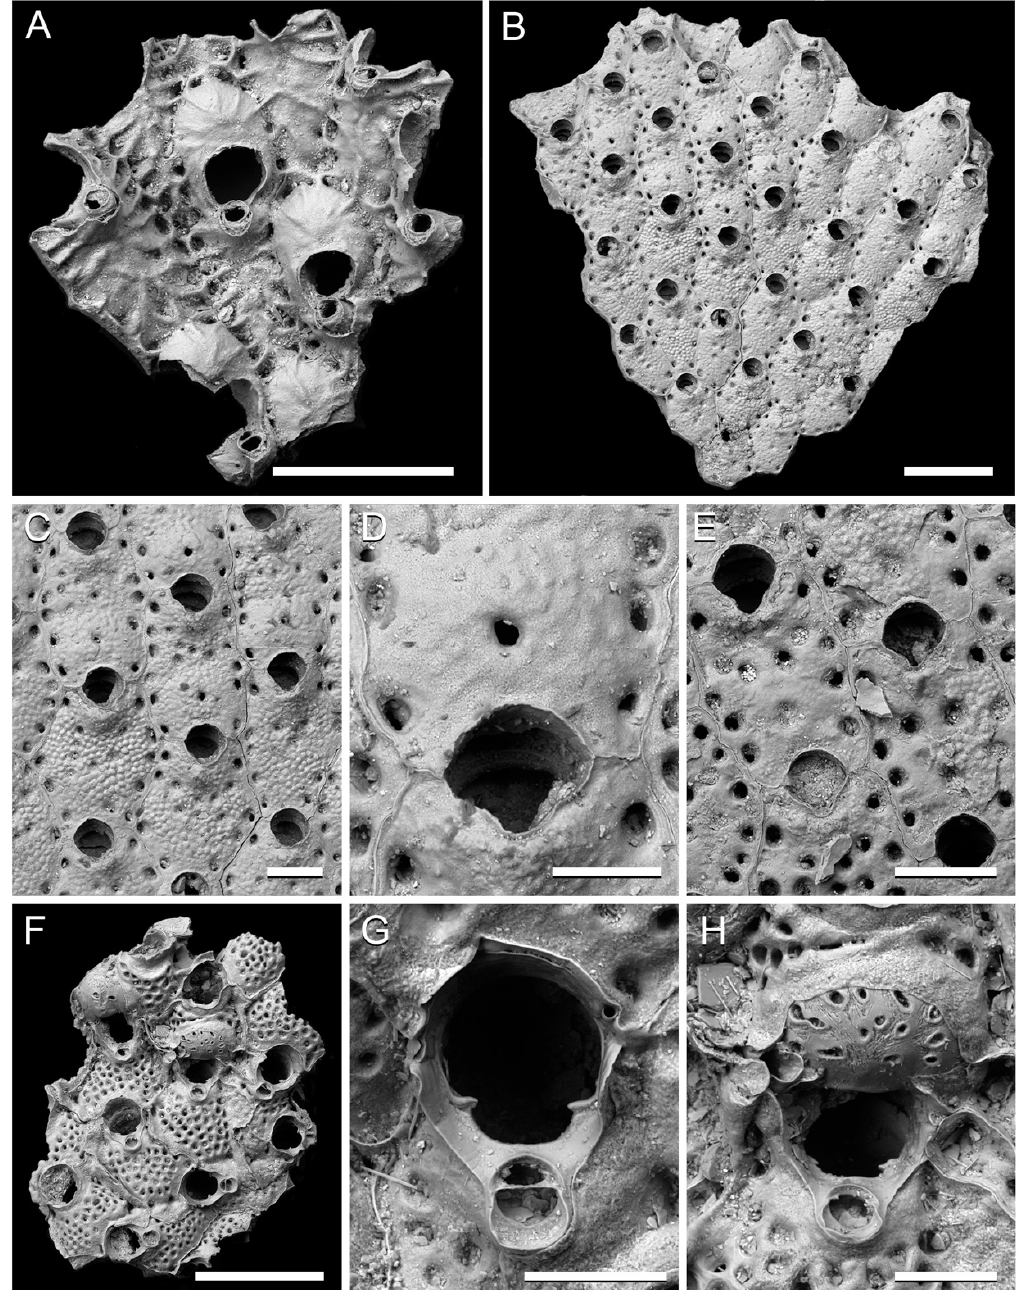
Figure 6. Cheilostome bryozoans from the Clyde Clay Formation of Garvel Park, Greenock, Scotland. ( A ) Porella cf. alba (Nordgaard, 1906), small fragment of colony showing zooids and ovicells, NHMUK B1223l. ( B – E ) Stomacrustula sinuosa (Busk, 1860); ( B – D ) NHMUK D1311; ( B ) fragment of colony; ( C ) group of zooids; ( D ) ovicell and secondary orifice; ( E ) autozooids, NHMUK Jelly Collection ‘GP8b’. ( F – H ) Schizomavella porifera (Smitt, 1868), NHMUK B1223i; ( F ) colony fragment from early astogeny; ( G ) orifice of infertile zooid with suboral avicularium; ( H ) orifice and ovicell. Scale bars: A, B, F = 500 µm; C, E = 200 µm; D, G, H = 100 µm.